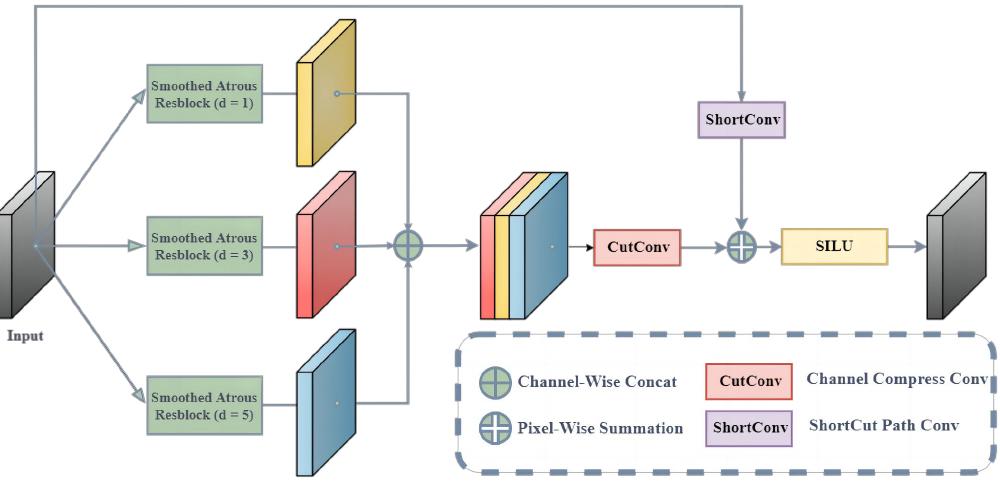
Figure 3. Smoothed atrous convolution (SAC) structure diagram.